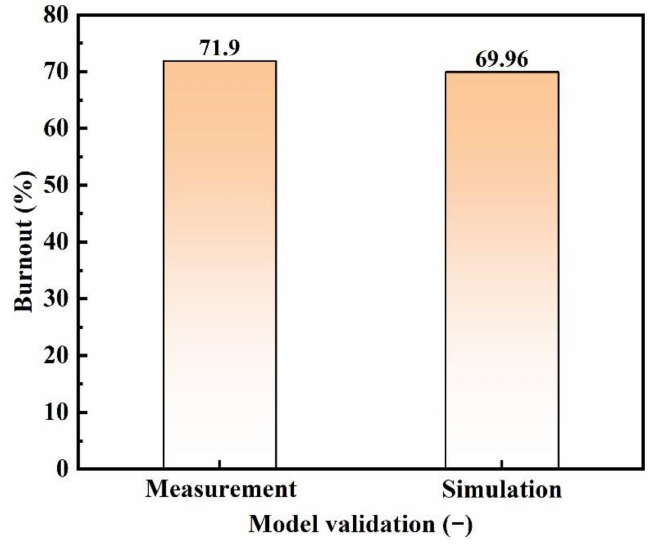
Figure 2. Model validation of the simulation results with the experimental results data from [29].